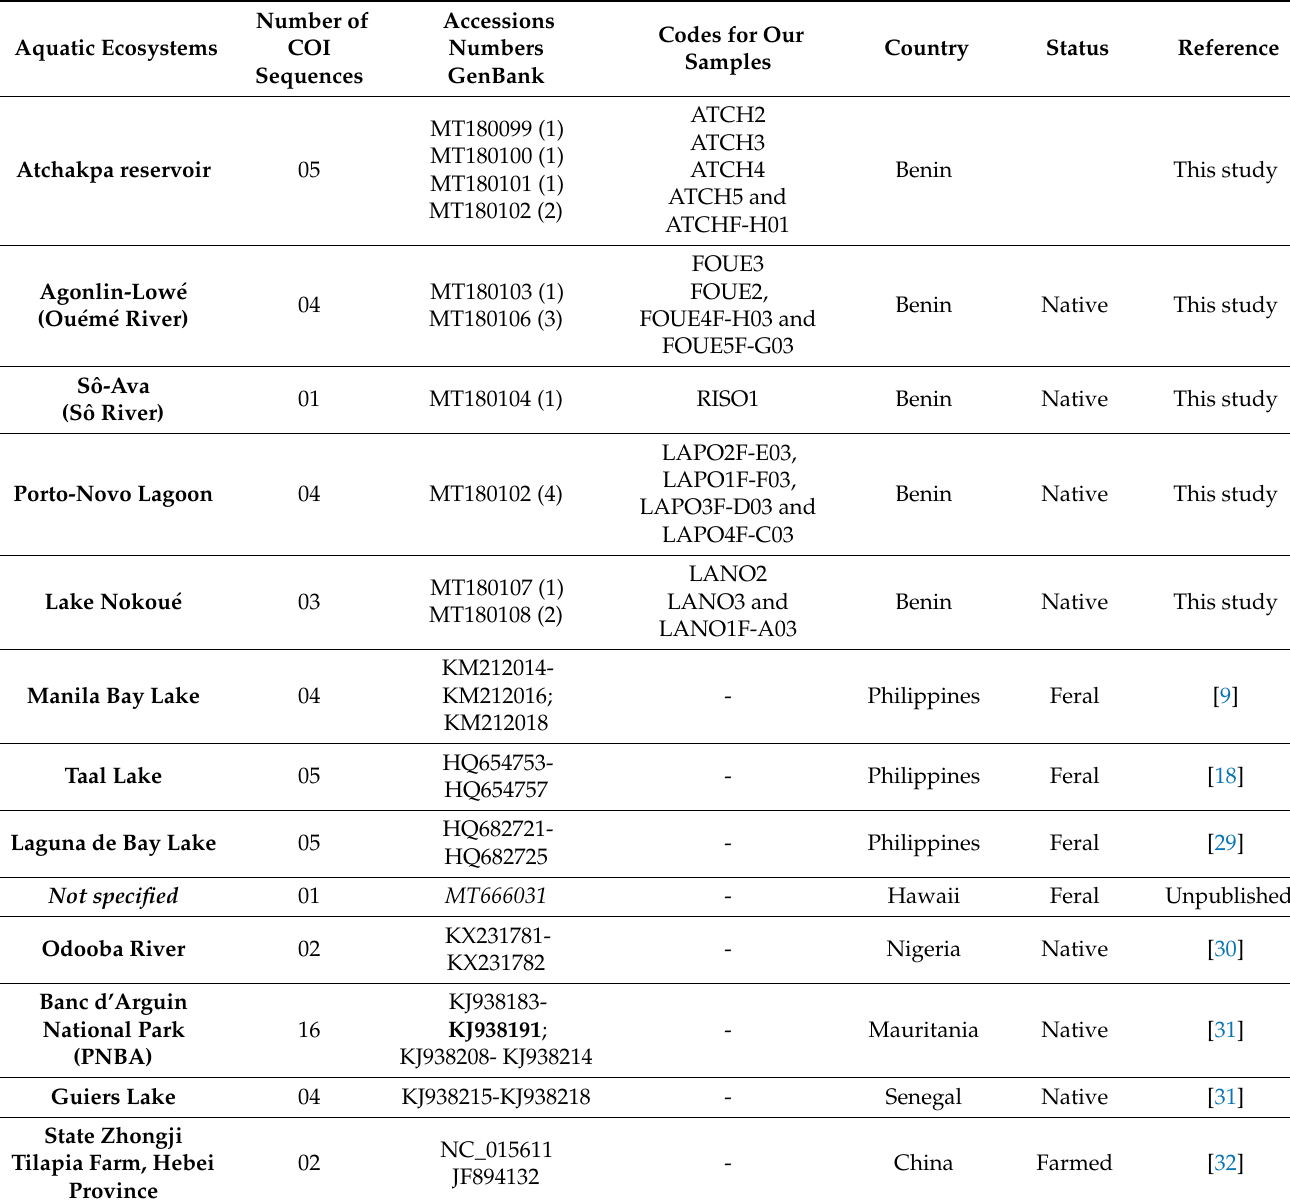
Table 1. Information on newly generated COI sequences of S. melanotheron and those retrieved from GenBank.